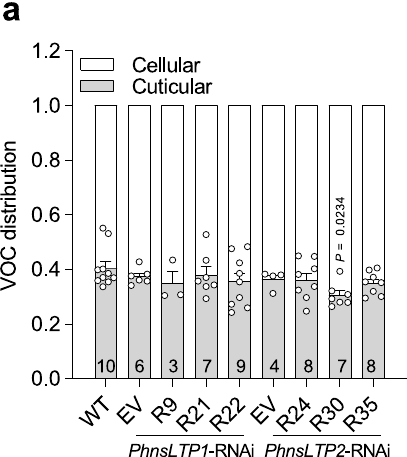
Fig.4|VOCdistributionin2-day-oldpetunia fl owers. CellularandcuticularVOC distributioninpetunia fl owersofWT,EVcontrol,andthreeindependent PhnsLTP1 - and PhnsLTP2 -RNAi lines ( a ) and PhnsLTP3 -RNAi lines ( b ) analyzed at 22:00h. P -valuesweredeterminedbyone-wayANOVAwithDunnett ’ smultiplecomparisons